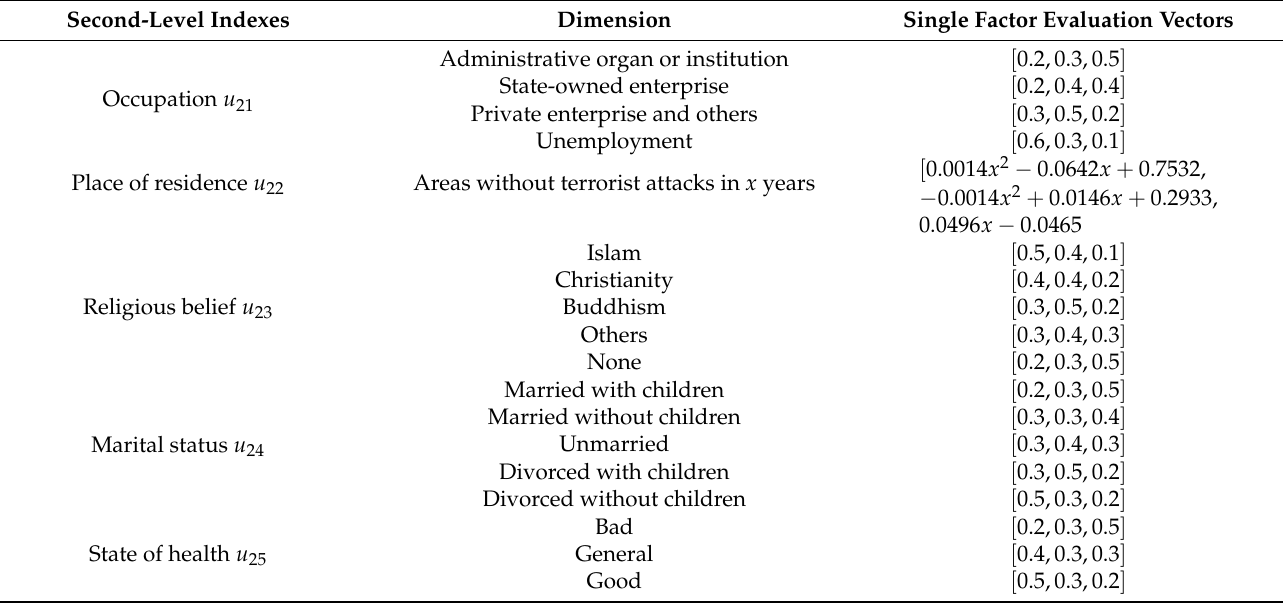
Table 10. Single factor evaluation of personal status